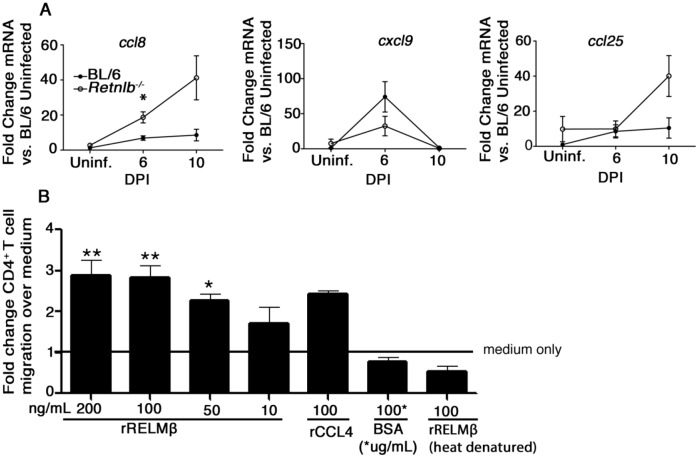
RELM-β acts as a CD4+ T cell chemoattractant.(A) qPCR analysis of chemokine genes involved in T-cell recruitment in colonic tissues of uninfected or infected C57BL/6 and Retnlb
-/- mice at 6 and 10 DPI. Results are means of n = 4–8 mice/group, pooled from 2 independent experiments. *P < 0.05 Retnlb
-/- 6 DPI vs. C57BL/6 UI, Bonferroni’s post-test following 1-way ANOVA. (B) Graph showing percent CD4+ T cells migrating toward RELM-β in a chemotaxis assay. Results are representative of 3 independent experiments, 4 replicates/group. *P < 0.05; **P < 0.001. Error bars = SEM.